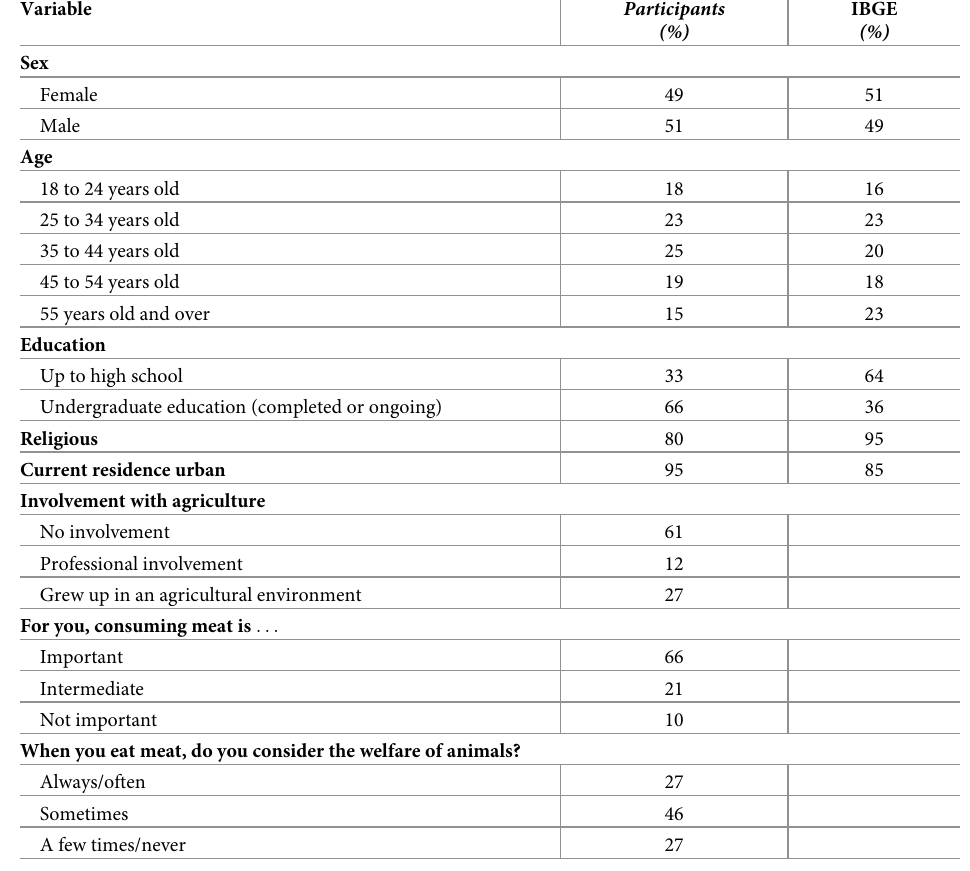
Table 1. Demographics of survey participants (n = 570) and of the associated general population living in south- ern Brazilians according to latest Brazilian Institute of Geography and Statistics (IBGE) census [35].